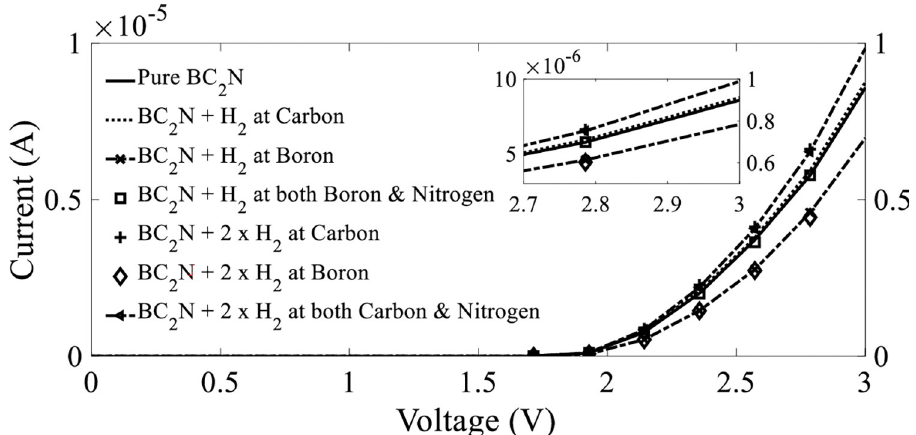
Fig 15. Current–voltage (I–V) characteristics before and after the adsorption of H 2 gas molecules on BC 2 N at a temperature of 500 K.